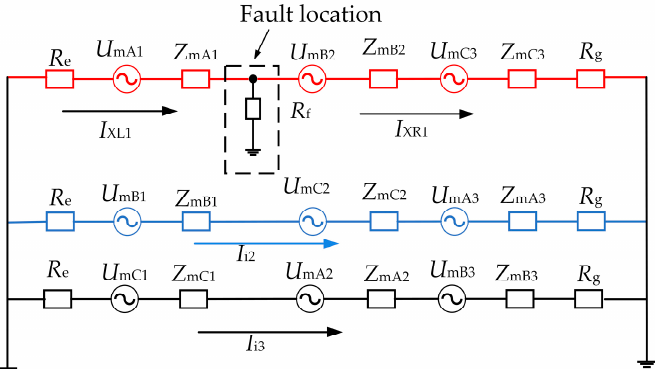
Figure 8. Equivalent circuit diagram of grounding fault of cable joint JA1.